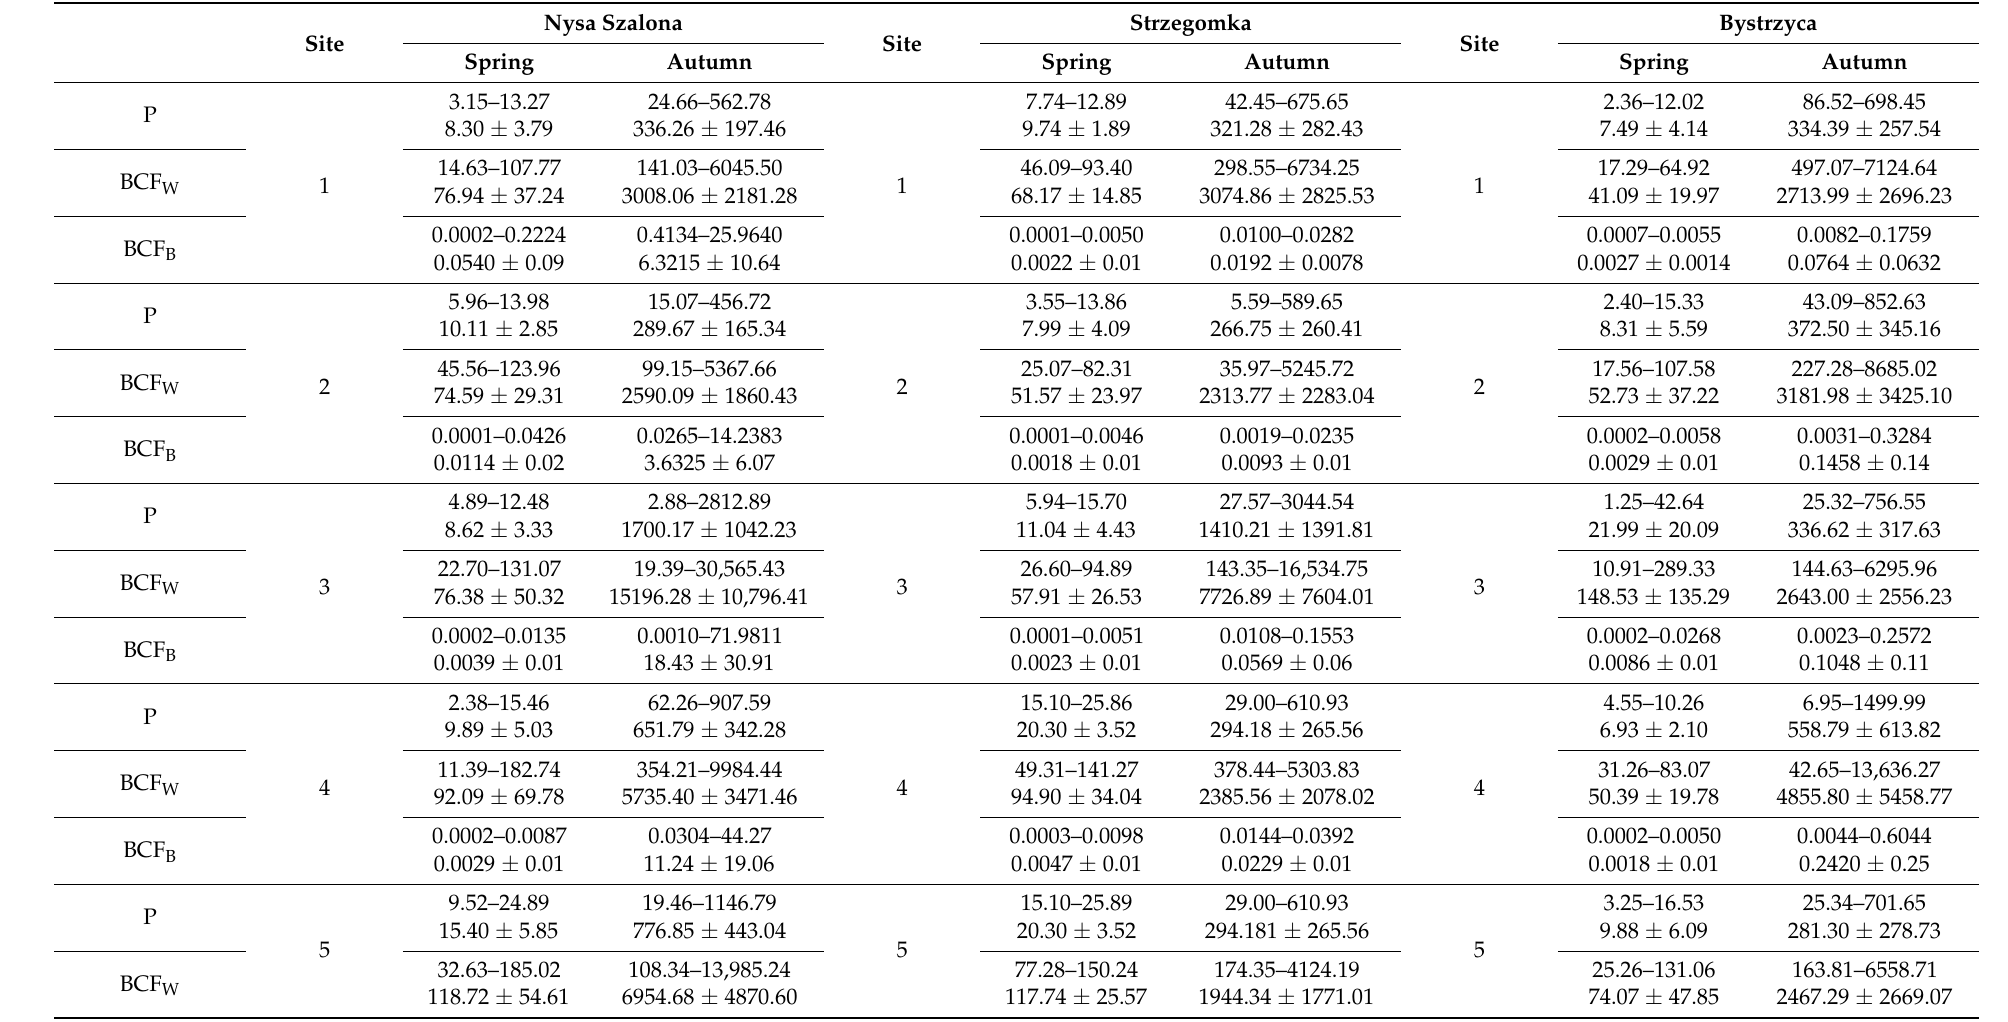
Table 3. Aluminum content in aquatic plants (mgAl · kg − 1 on dry weight basis) and aluminum accumulation in spring and